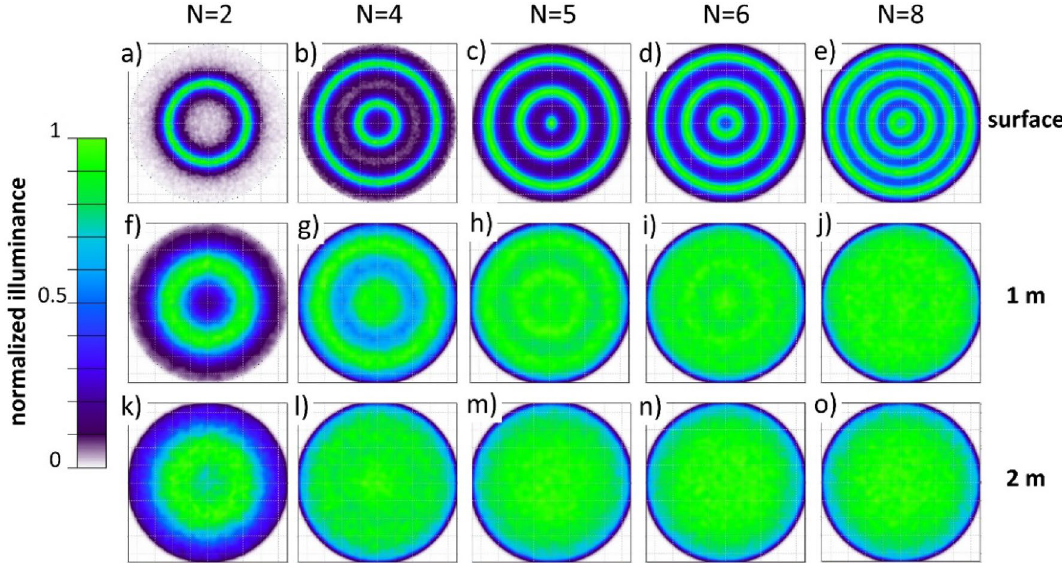
Figure 2. Simulation results top view. Modeled horizontal illuminance distribution of the skyglow system for different water depths and for different geometries of ring-shaped light emitters. The upper row ( a - e ) shows the light distribution at the water surface, the middle row ( f - j ) the light distribution at 1 m and the lower panels ( k – o ) at 2 m below the water